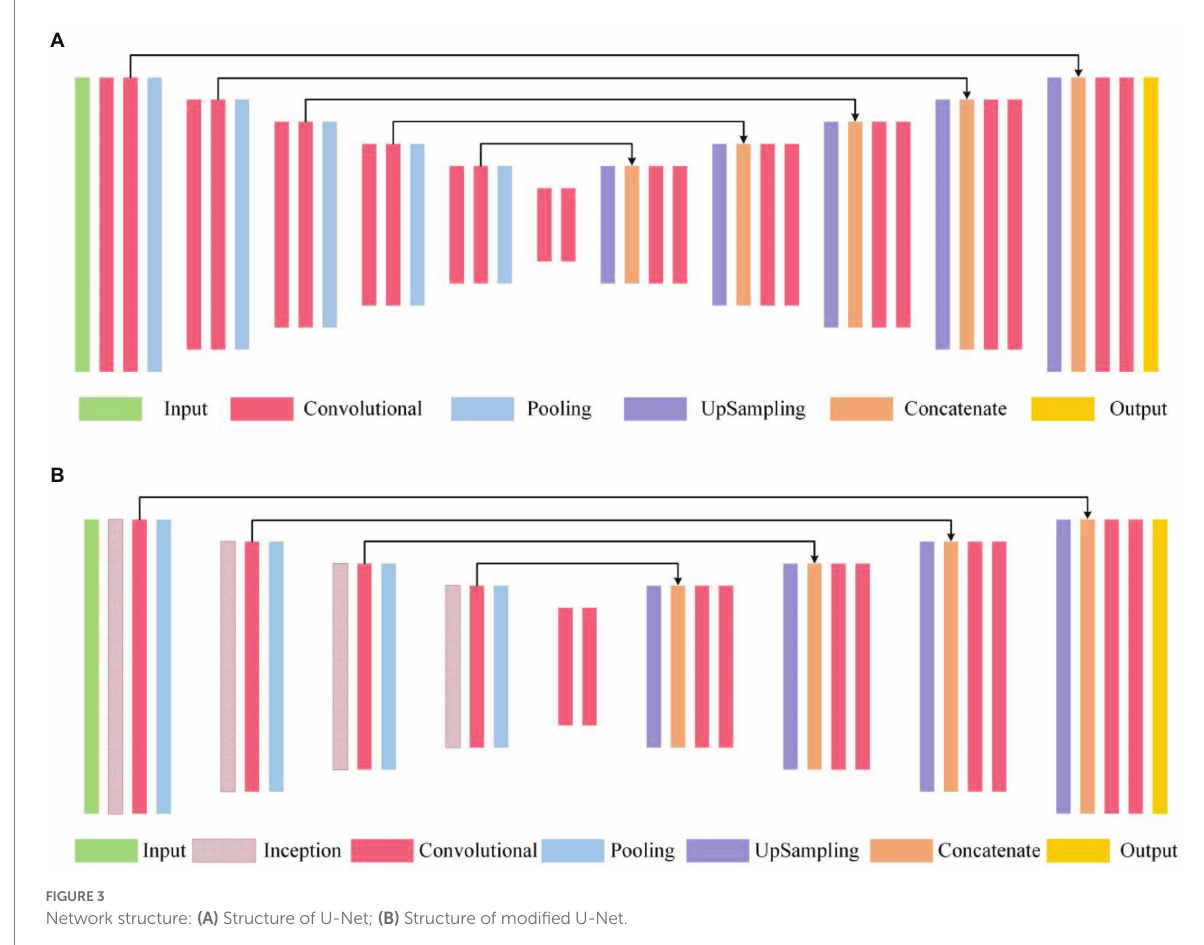
FIGURE 3 Network structure: (A) Structure of U-Net; (B) Structure of modified U-Net.